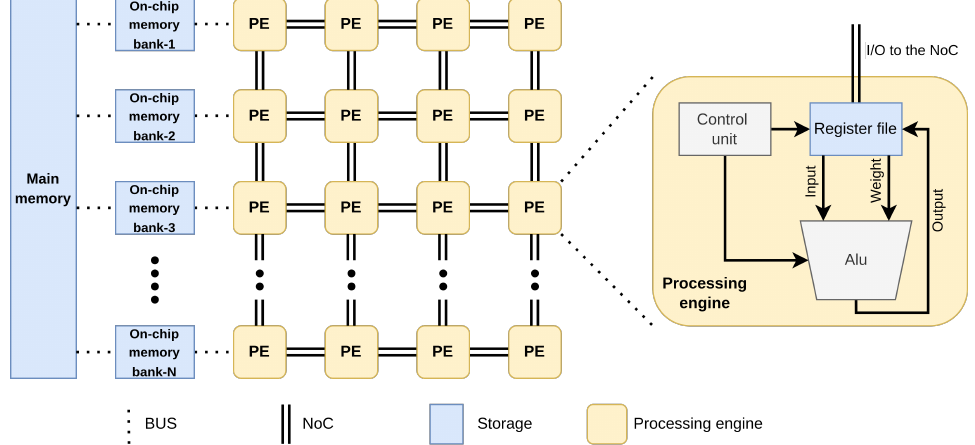
Figure 1. Hardware model with a memory hierarchy composed of three elements (main memory, on-chip memory, and register file) and an array of processing engines interconnected with a network-